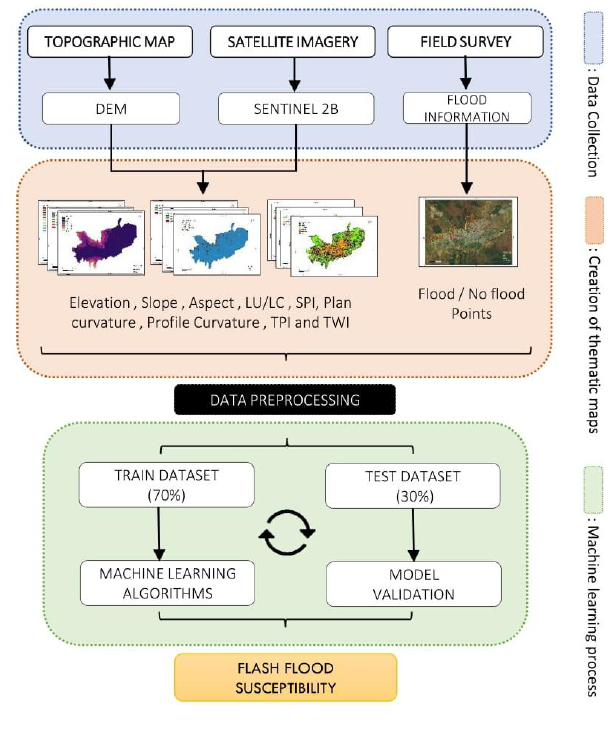
Figure 2 : Flowchart of the